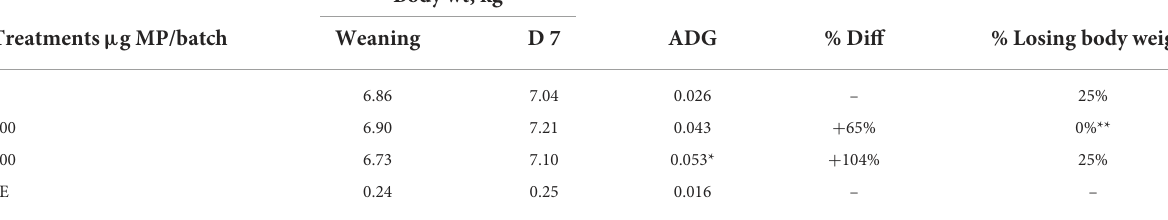
FewerpigslostweightwiththeMAformoftheMP. MeansfavortheMAandMAME. N = 48pigs;4pigs/pen;3pens/treatment. * PigsexposedtoMPinMAformdifferedfromcontrolbyFisher’sExacttest,P < 0.05.%LosingbodyweightwasnotdifferentcomparingcontrolwiththeMAMEformofMP. TABLE 5 Dose response for MP in EVA cookies (Study